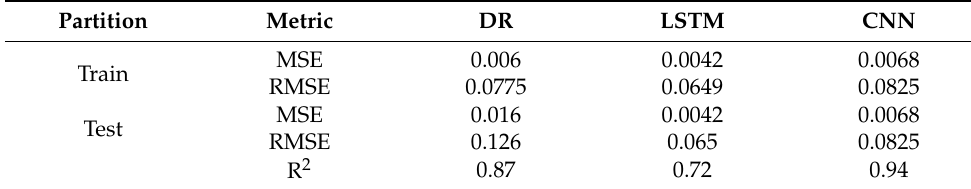
Table 3. Averaged error obtained with the second